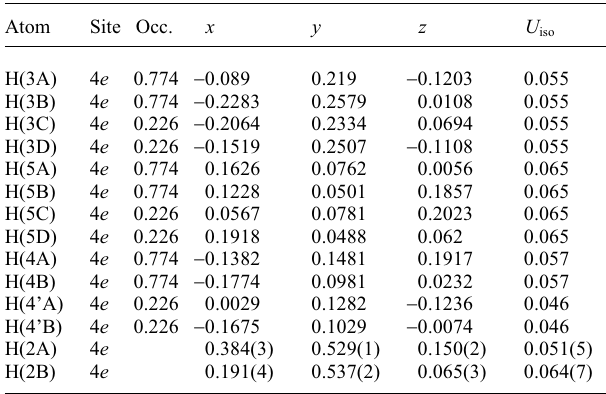
Table 2. Atomic coordinates and displacement parameters (in Å 2 )